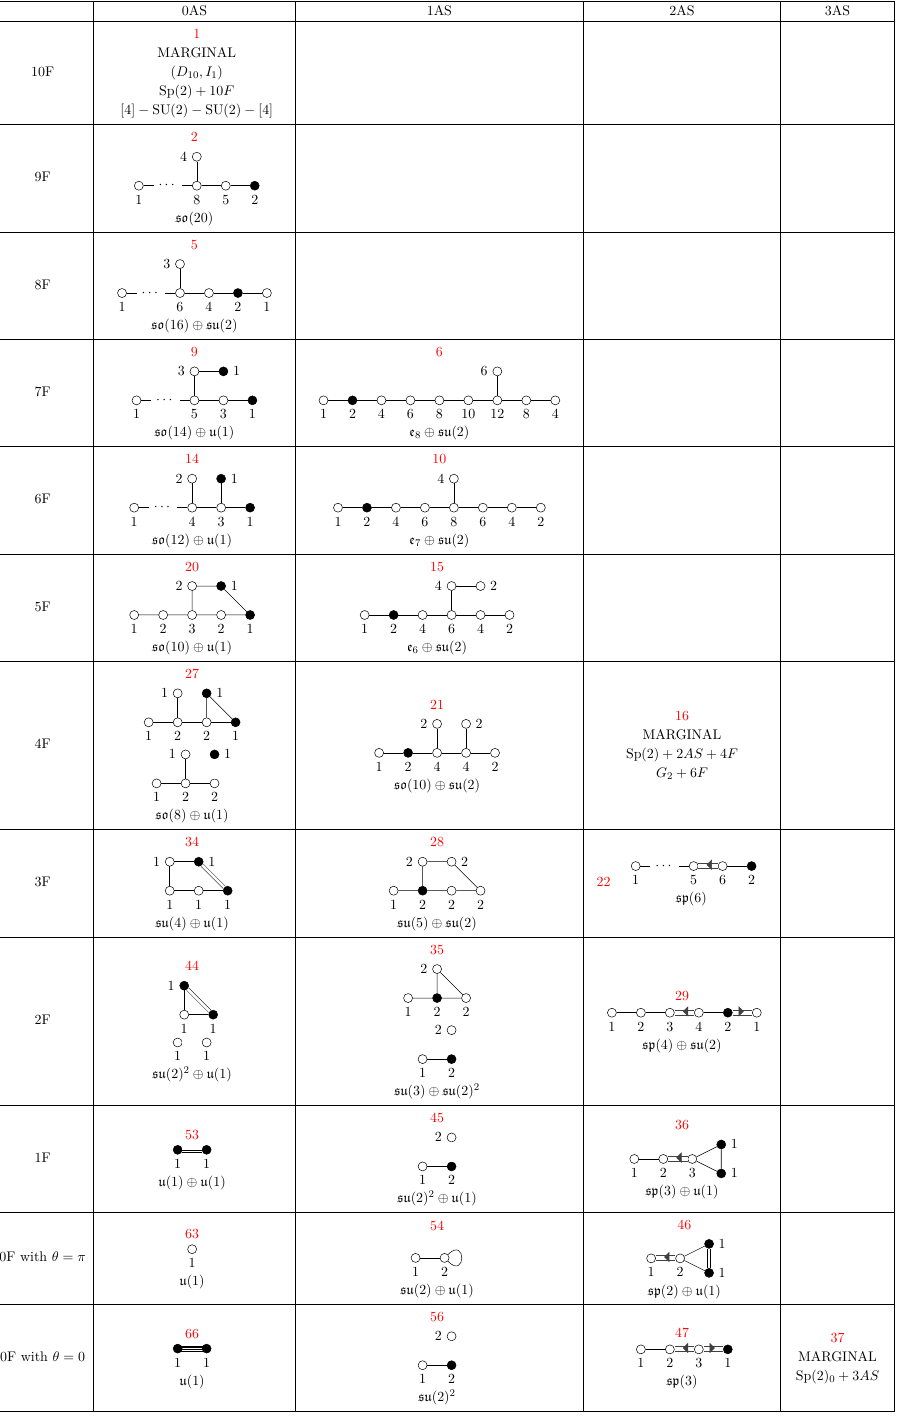
Table 9 . Decoupling tree of Rank 2 continued: shown are the magnetic quivers for SCFTs, which have IR descriptions as Sp(2) gauge theories. The lines correspond to the number of fundamentals and the columns to the number of antisymmetric hypermultiplets. When there are no fundamentals, we have to distinguish according to the value of the θ